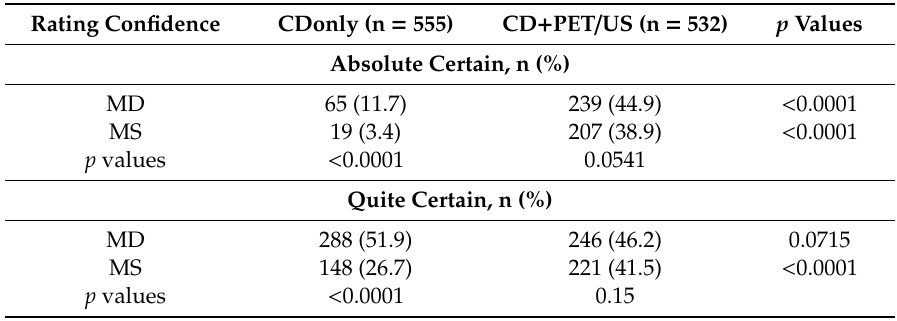
Table 2. Confidence in the functional assessment of thyroid nodules (TN) in conventional diagnostics (CDonly) versus CD + I-124-PET / US fusion imaging (CD + PET / US); comparison between the ratings of nuclear medicine physicians (medical doctors) and medical students